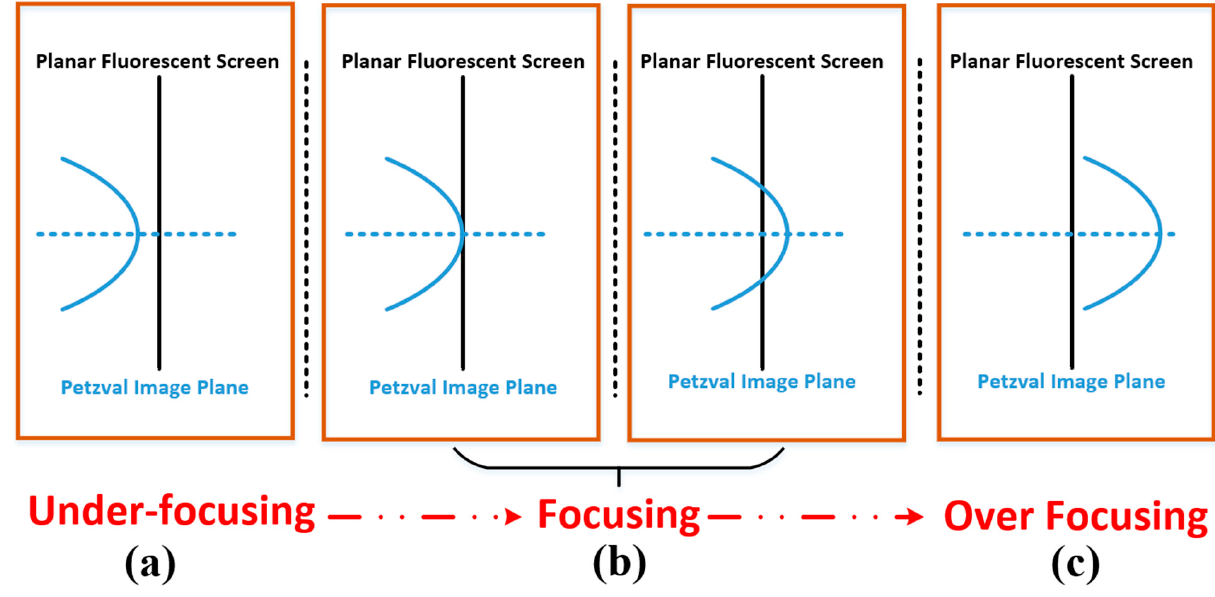
Figure 3. Distance between Petzval image plane and planar fluorescent screen.